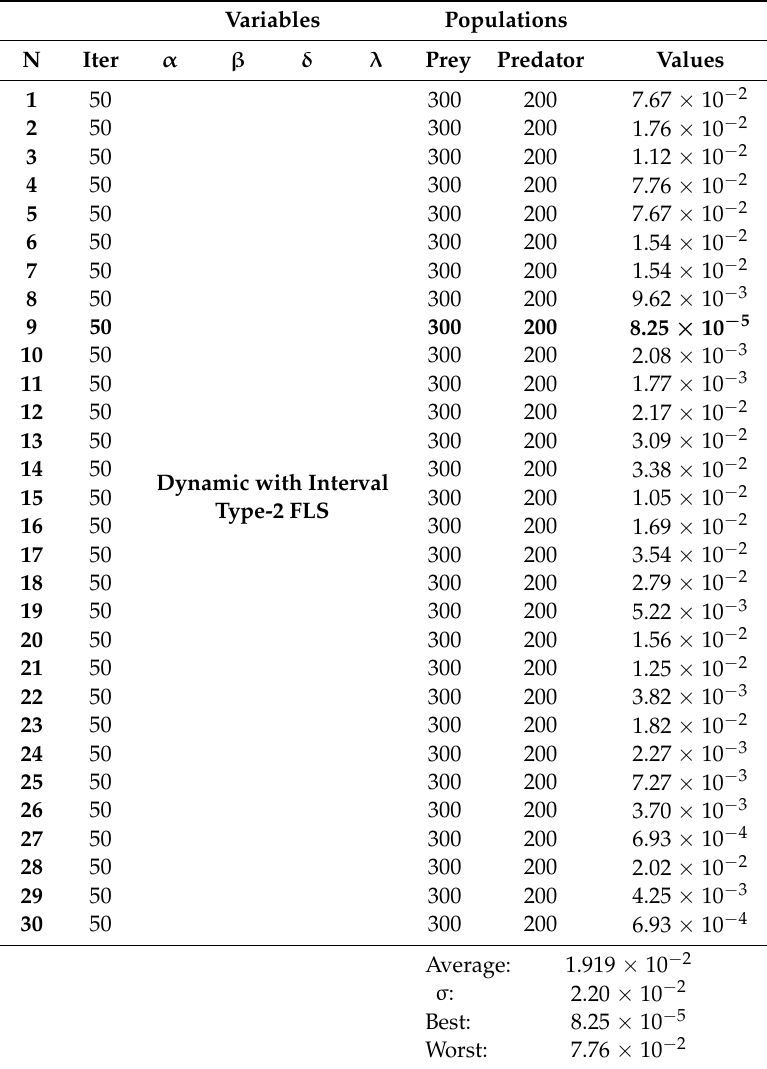
Table 1. Results obtained and parameters of the algorithm.